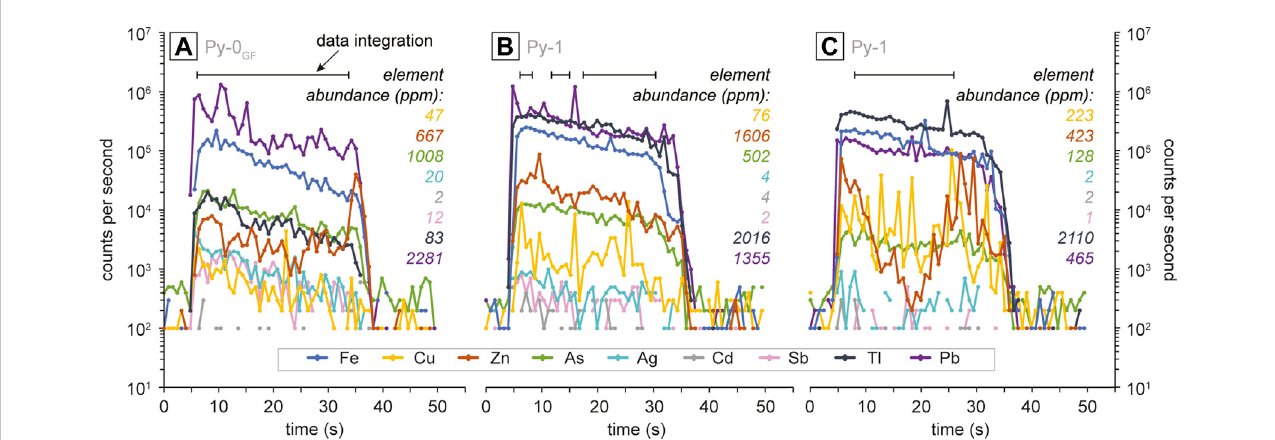
Time-resolved LA-ICP-MS pro fi les of representative analyses of (A) Py-0 from George Fisher (Py-0 GF ) and of Py 1 (B,C) . The colours represent individual elements,theareasselectedfordataintegrationaredenotedbyblackbarsabovetheablationpro fi les,andelementabundancesfortheindividualanalysesare reported in the respective colours.